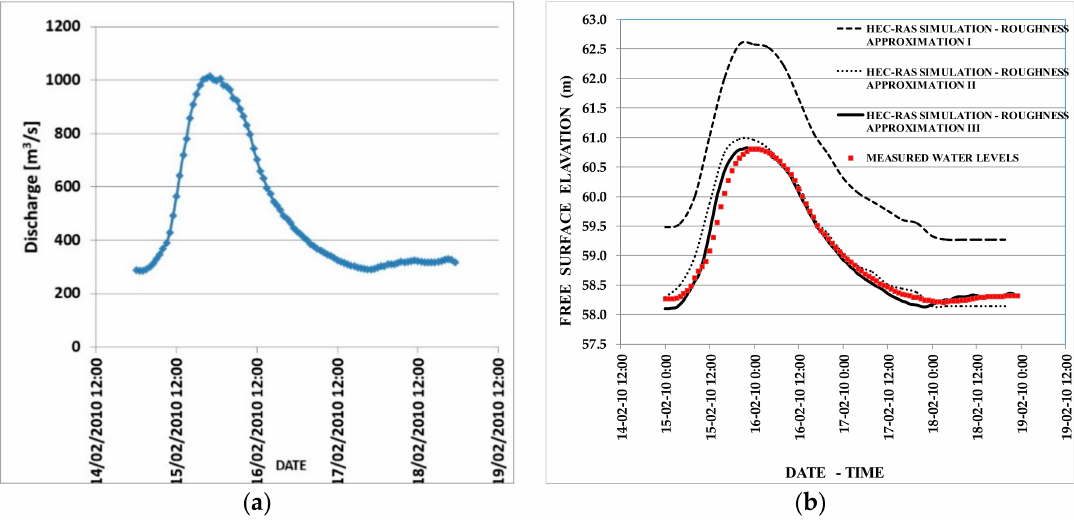
Figure 3. ( a ) Inflow hydrograph (hourly discharges) as an upstream boundary condition at the simulated Greek part of the Arda river on February 2010; ( b ) Free water surface elevation at the control section of Komara, from measurements and from numerical simulation (February 2010) considering three different approximations of the Manning